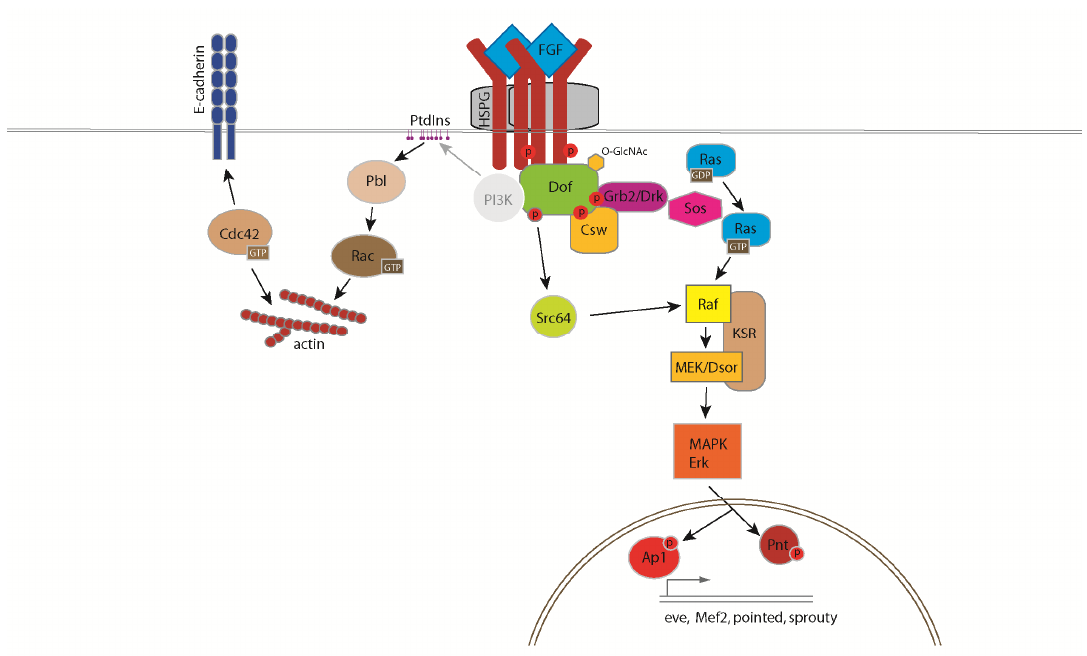
Figure 2. Schematic model of the FGF signalling cascade in Drosophila melanogaster. FGFs bind to their FGFRs and this interaction is stabilized by heparan sulfate proteoglycans (HSPG). Activation of the FGFR leads to auto- and trans-phosphorylation of their tyrosine kinase domains and to phosphorylation of its adaptor protein Dof. Dof protein is O -GlcNAcylated ( O -GlcNAc) and possesses multiple clusters of tyrosine residues directing the signal towards various cascades, three of which—the Csw/Shp2, Grb2/Drk and Src64B pathways—have been proposed to contribute to MAPK activation. This route of FGF signalling is responsible for inducing gene transcription, and executing proliferative and anti-apoptotic responses. Dof also contains a putative binding site for PI3K that could locally modify the phosphatidylinositol (PtdIns) composition of the plasma membrane and thus recruit downstream signalling components for example the RhoGEF Pbl. Pbl acts on the Rac pathway to promote the formation of actin rich protrusions in the mesoderm. Actin polymerisation is required for protrusion formation in a Rac-, Cdc42- and FGF-dependent fashion. Putative interactions are indicated as grey arrows and the putative component of the Drosophila FGF pathway, PI3K, is represented as a circle with no